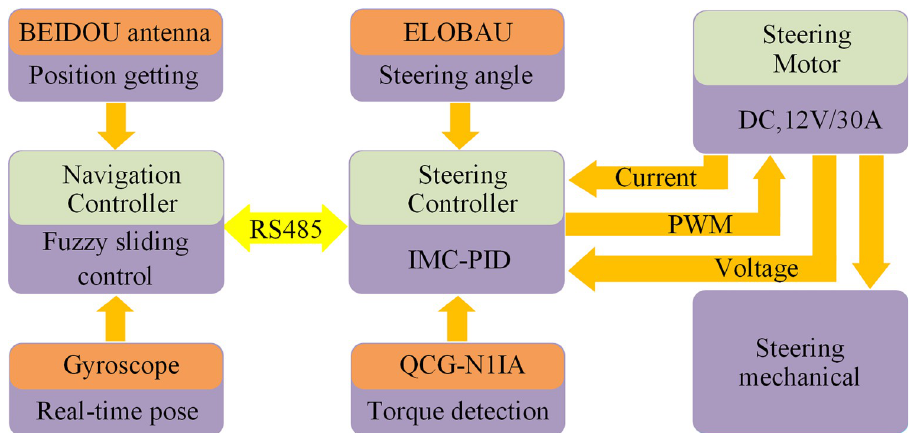
Fig 2. Hardware structure of the trajectory following the system.